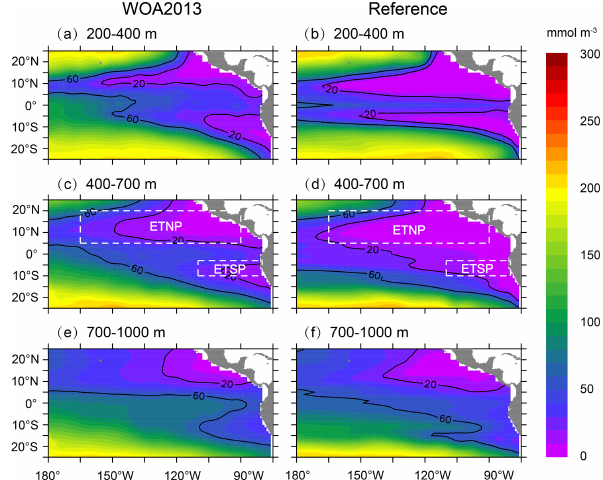
Figure 2. Comparisons of DO concentration between WOA2013 (a, c, e) and the reference run (b, d, f) over 1991–2010. White dash lines in (c) and (d) denote two boxes for ETNP (5–20 ◦ N, 165– 90 ◦ W) and ETSP (10–3 ◦ S, 110–80 ◦